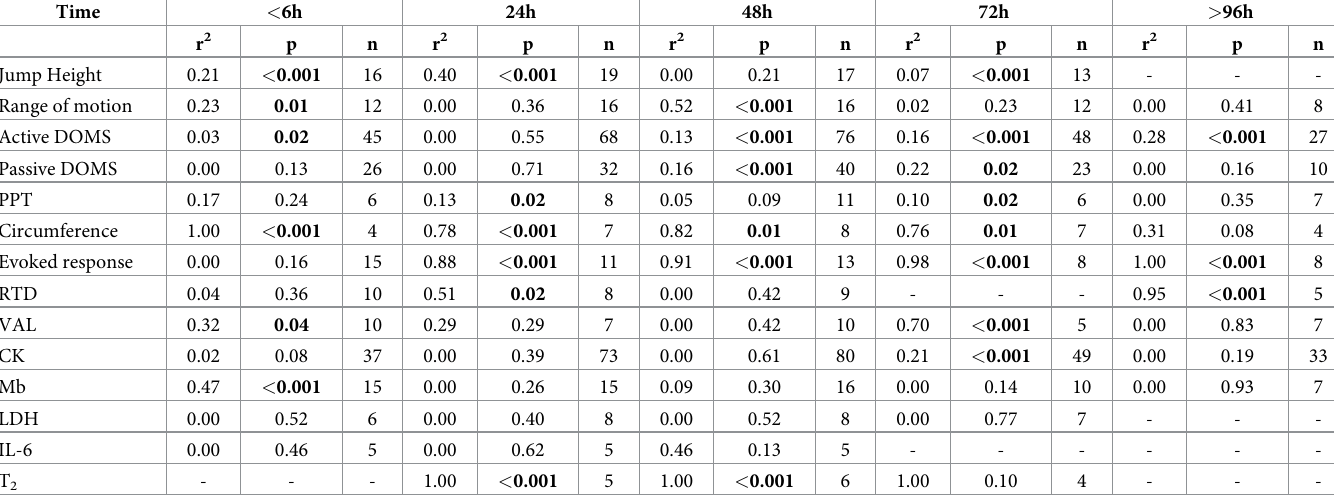
Table 2. Coefficient of determination (r 2 ) and p-value of meta-regressions between peak reductions in maximal voluntary contraction (MVC) torque and changes in jump height, range of motion, active DOMS, passive DOMS, pain pressure threshold (PPT), limb circumference, evoked response, rate of torque development (RTD), voluntary activation level (VAL), creatine kinase (CK), myoglobin (Mb), lactate dehydrogenase (LDH), interleukin-6 (IL-6) and transverse relaxation time (T 2 ). “n” represents the number of studies included in the analysis. Results with a P-value < 0.05 are considered significant and are displayed in bold